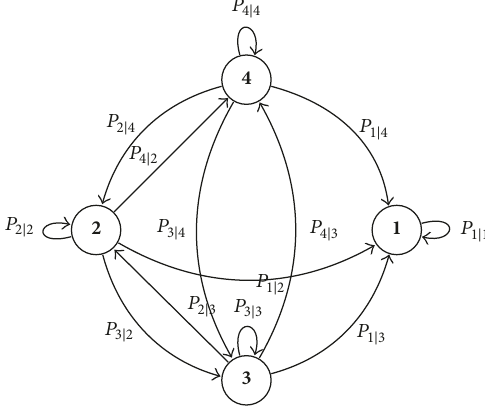
Figure 13: State diagram of the rover position